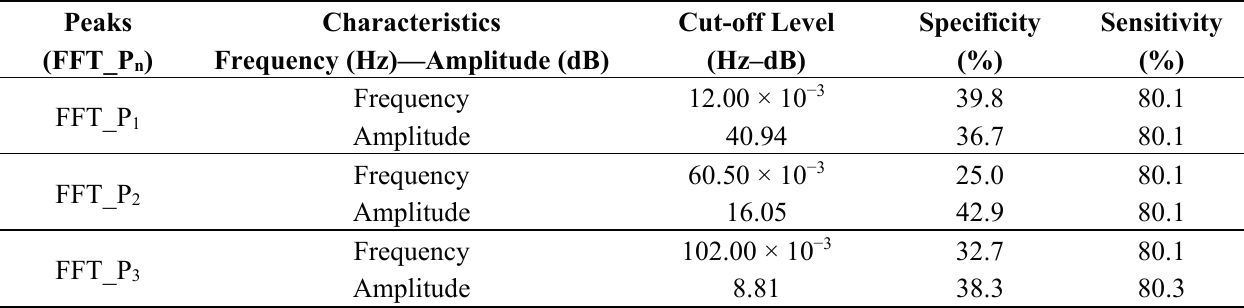
Table 12. Accuracy of the studied frequency peaks reported in terms of sensitivity and specificity of each peak at specific cut-off